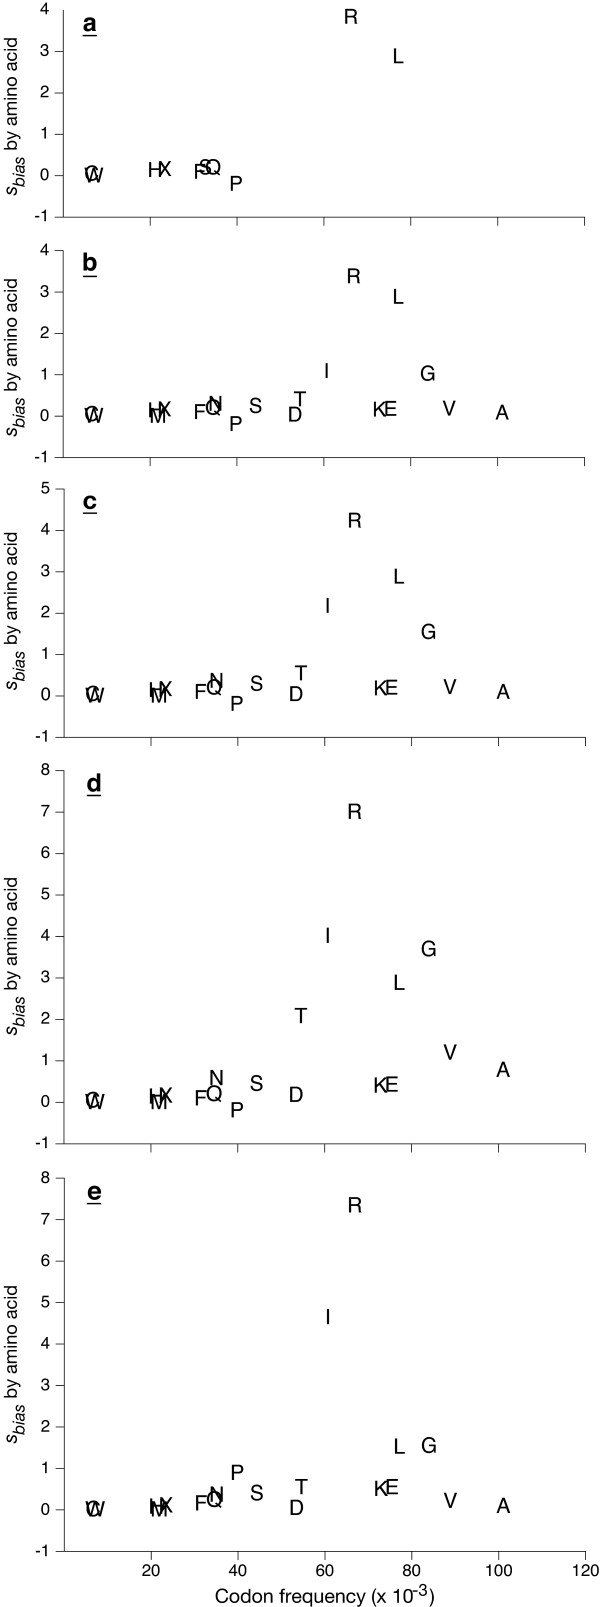
Translation rate benefit of codon bias by amino acid The translation rate benefit of codon bias for each amino acid in E. coli is plotted versus the frequency of the amino acid in the E. coli proteome. Each amino acid is represented by its one-letter abbreviation. Panels a – e represent Scenarios 1 – 5, respectively (described in Methods). For all panels, the duration of translocation is assumed to be negligible and the benefit is estimated in comparison to uniform codon use (corresponding to the white bars of Figure 1). Only a few amino acids encoded by one or more rare codons contribute disproportionately to the total translation rate benefit of codon bias in E. coli.